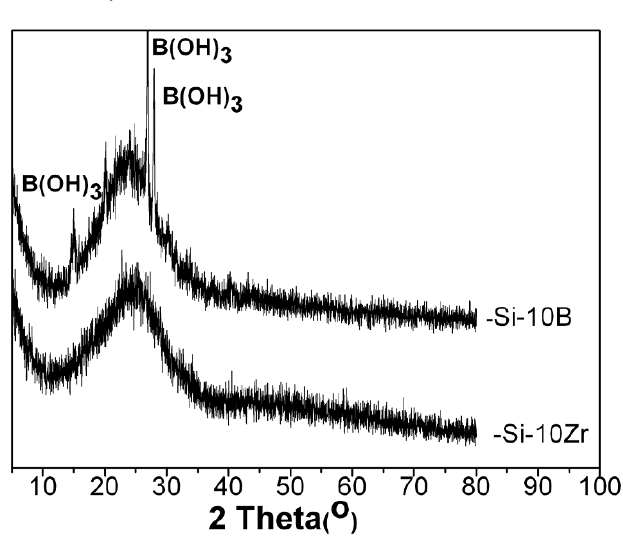
Figure 3. XRD patterns of nanostructured hybrid materials Si-10B and